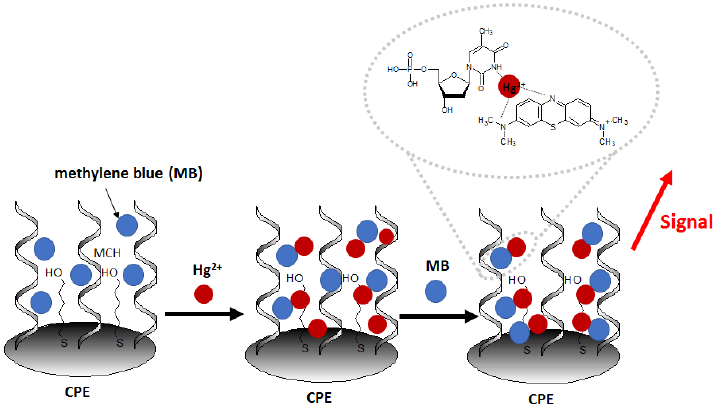
Figure 8. Schematic representation of construction and working principle of aptasensor using electrospun nanofibers polyethersulfone and quantum dots on carbon paste electrode.